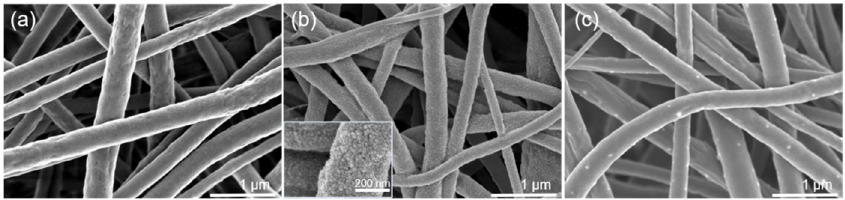
Figure 6. SEM images of ( a ) PVDF, ( b ) PVDF-CF, and ( c ) PVDF-BZ membranes. Scale bar is 1 µm.